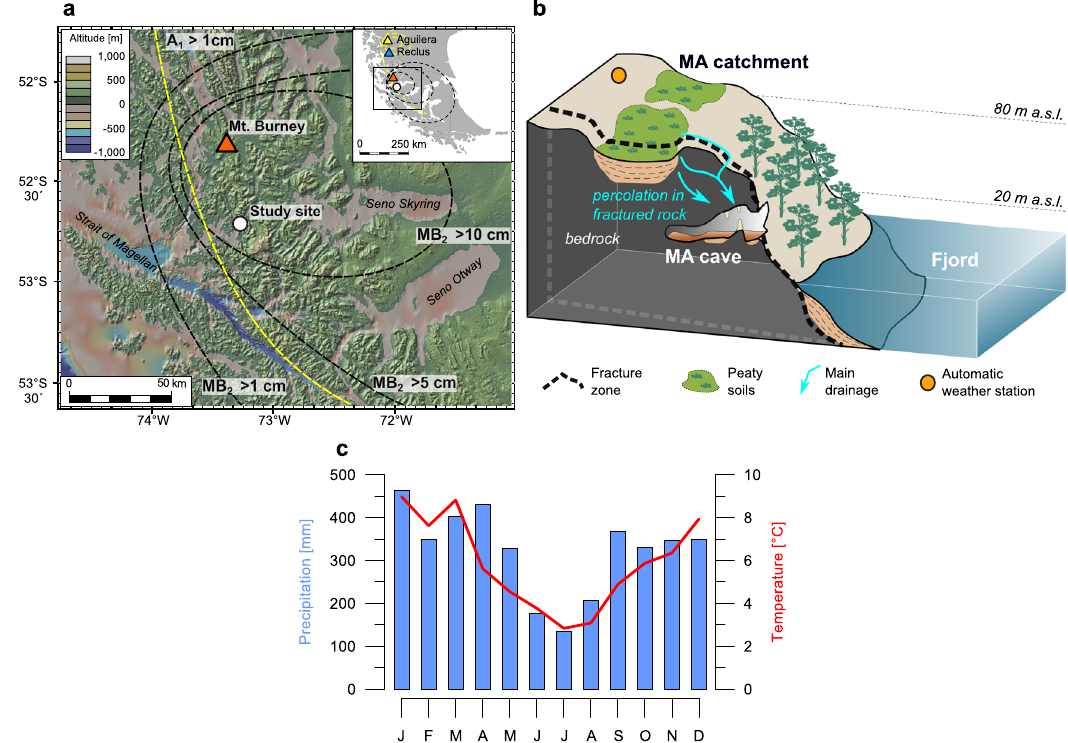
Fig. 1 Location of the study area and site characteristics. a The study site at the windward side of the southernmost Andes, ~40 km S of the Mt. Burney volcano. Inserted isopach lines indicate the thickness and distribution of tephra deposits from the MB 2 and A 1 eruption 7 . In addition, Reclus and Aguilera volcanoes are shown. b Marcelo Arévalo 25 (MA) cave and its environmental context. The hydrological connection between the cave and its catchment is schematically illustrated. c Mean monthly precipitation and temperatures measured at the automatic weather station Arévalo 30 . Values were averaged from the time spans 2011 – 2012 and 2015 – 2016. The background map in a was generated with GeoMapApp 77,78